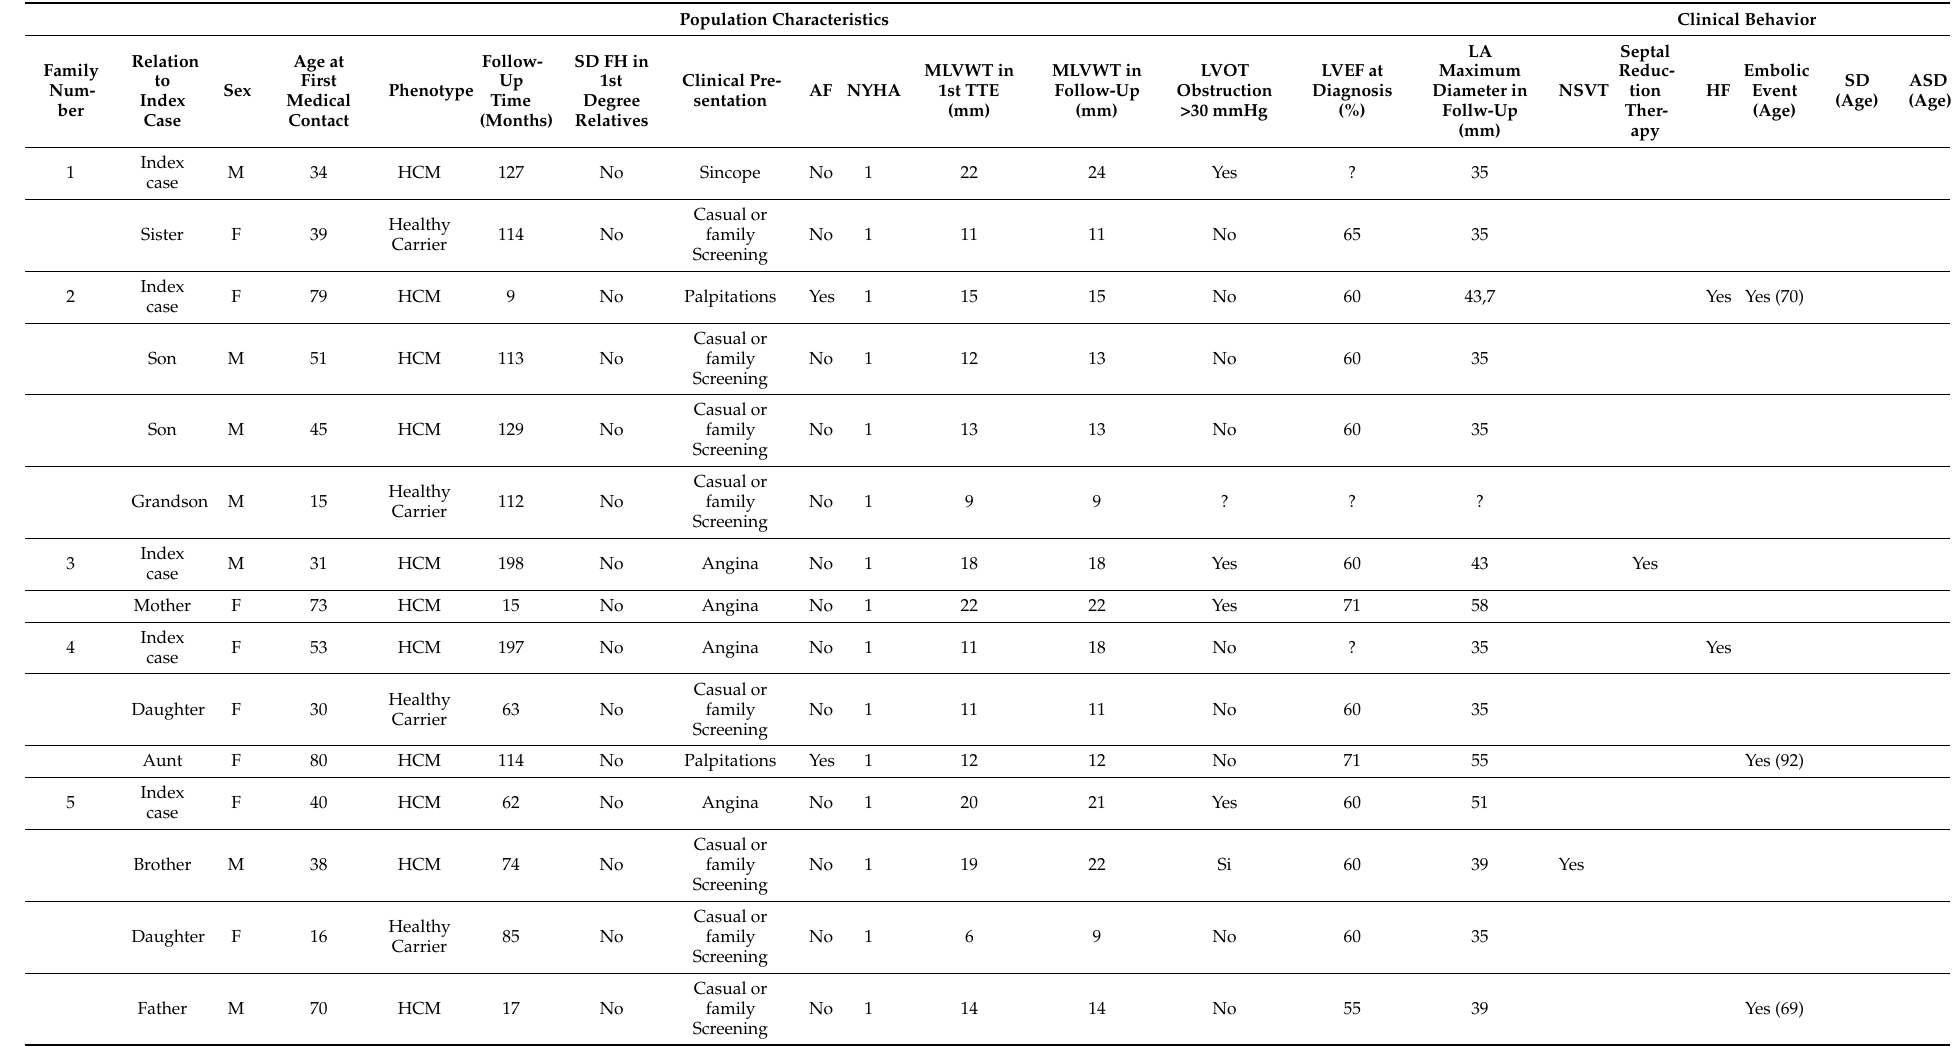
Table 1. Characteristics of the population with findings of the p.Arg652Lys variant in MYH7